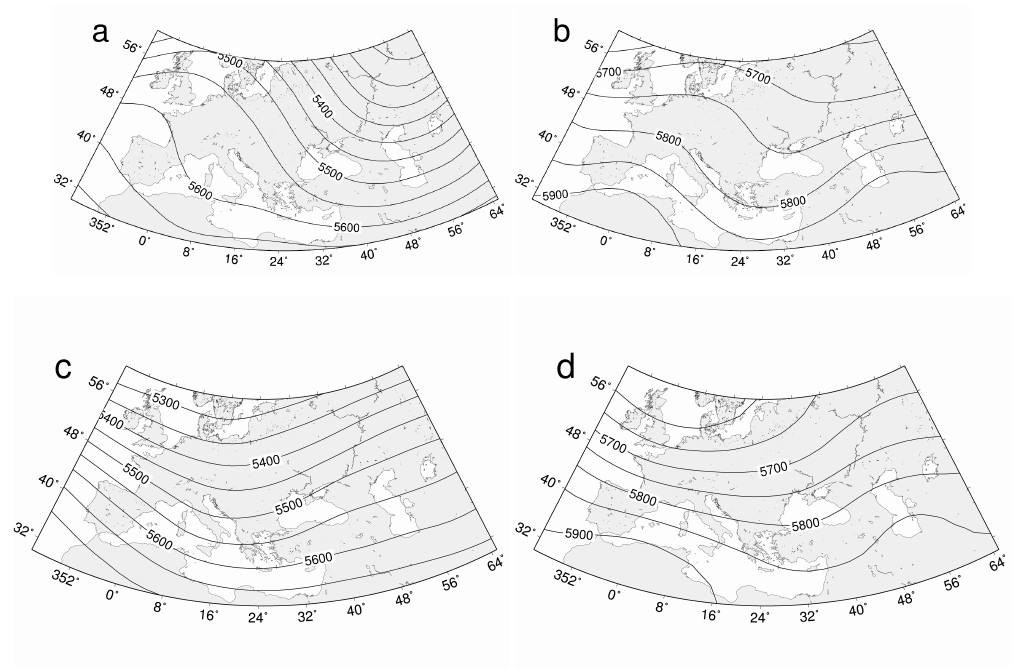
Fig. 1. Mean absolute geopotential heights (GPH) during NCP (+) in January (a) ; NCP (+) in July (b) ; NCP ( − ) in January (c) and NCP ( − ) in July (d)